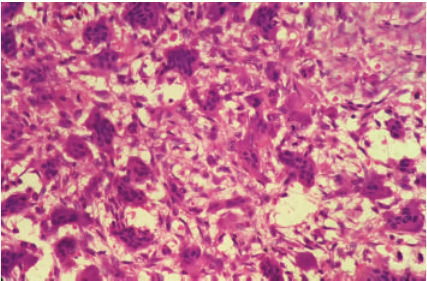
Figure 10: H&E 40x view showing cellular pleomorphism and mitotic